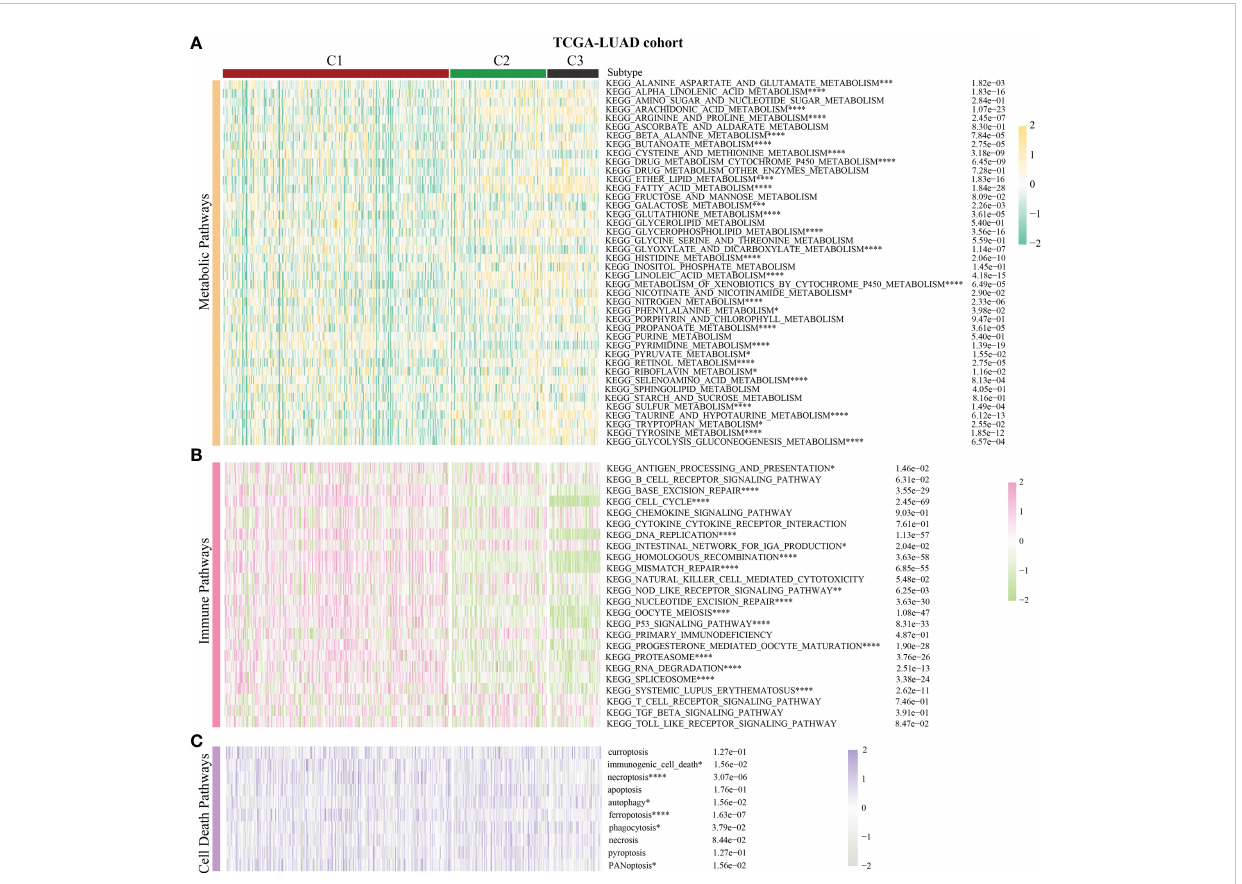
FIGURE 5 Correlation of the cell cycle-related gene scores with metabolic reprogramming, immunological microenvironment, and cell death pathways in LUAD. (A) Activity of well-recognized metabolic reprogramming in the three clusters for LUAD. (B) Activity of well-recognized immune pathways in the three clusters for LUAD. (C) Correlation between the cell cycle-related gene scores and cell death pathways for LUAD. * indicates p < 0.05; ** indicates p < 0.01; *** indicates p < 0.001; and **** indicates p <